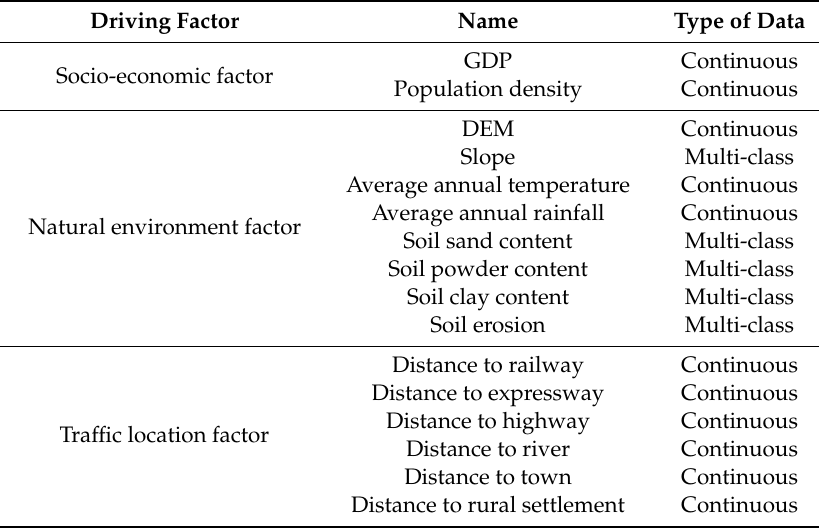
Table 4. Driving factors of land use